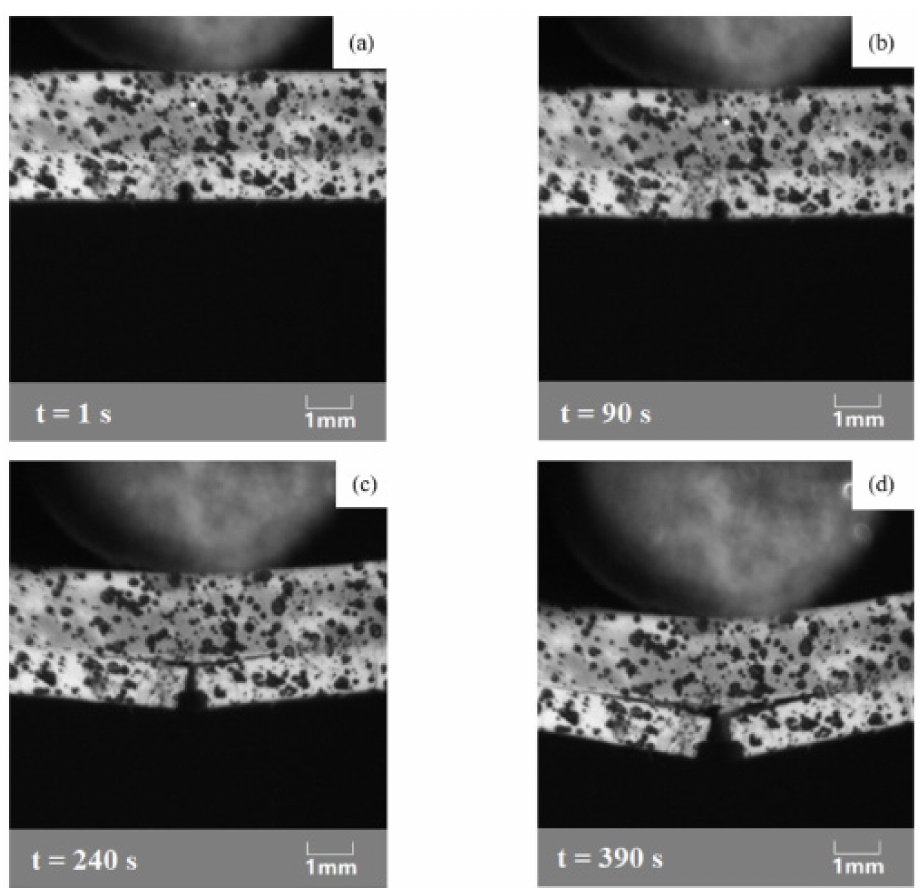
Figure 17. The crack initiation and propagation process detected at the room temperature (30 ◦ C): ( a ) Initial state; ( b ) the initiation of surface crack; ( c ) the initiation of interfacial crack between TC and BC; and ( d ) the propagation of interfacial crack [77].